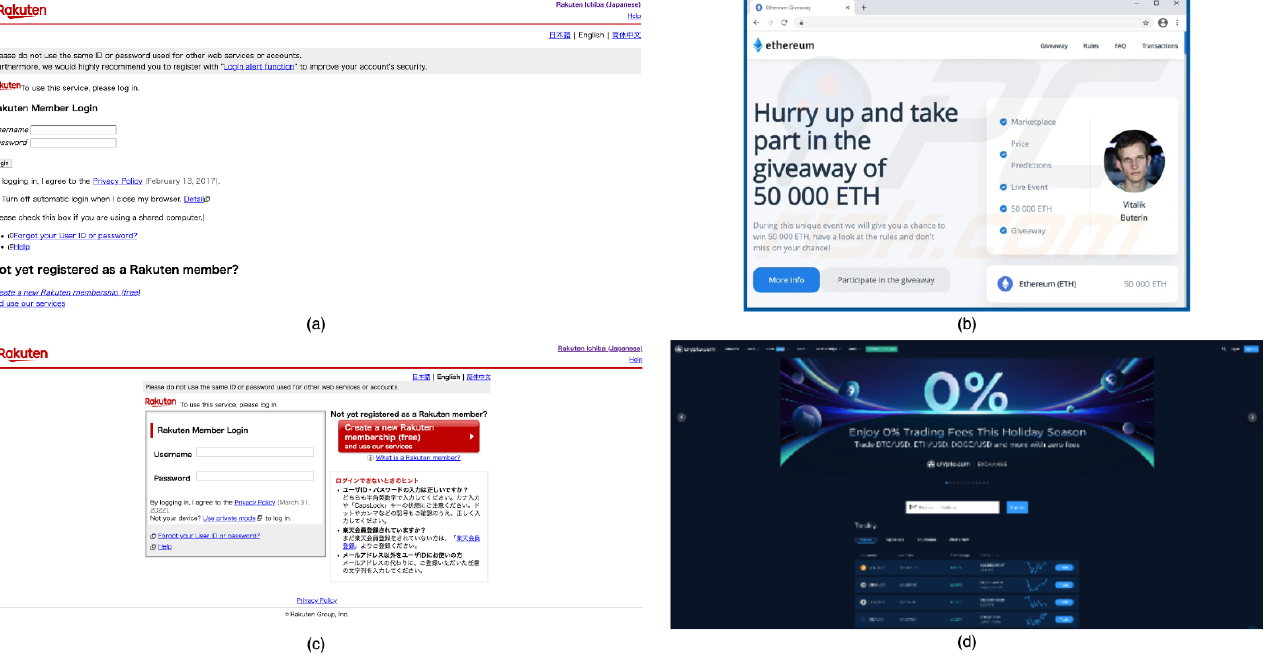
Figure 1. Some examples of malicious and legitimate webpages: ( a ) a phishing Rakuten website; ( b ) a fake cryptocurrency website; ( c ) a legitimate Rakuten website; ( d ) a legitimate cryptocurrency